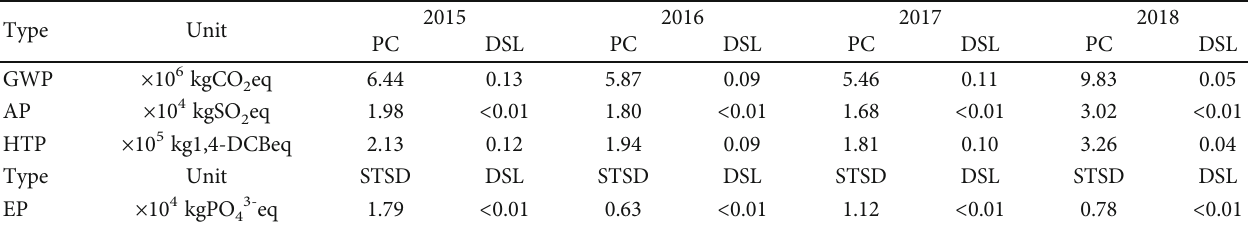
Table 6: Environmental impact potential values. PC: power consumption; DSL: domestic sludge land fi ll; STSD: sewage treatment station drainage.